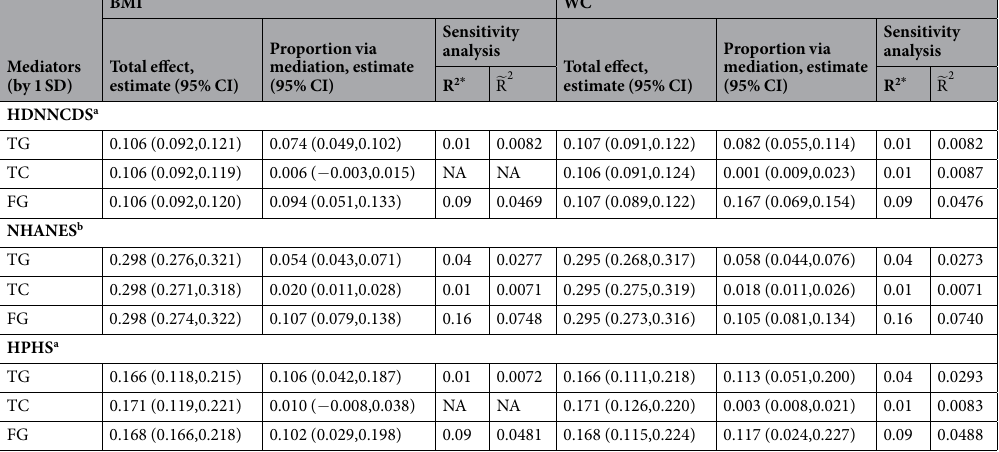
∼ 2 R , the proportion